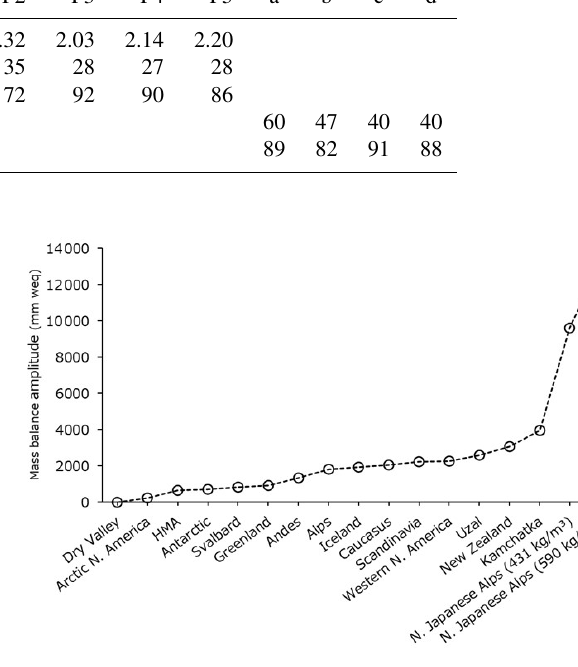
Figure 11. Mass balance amplitudes of glaciers.